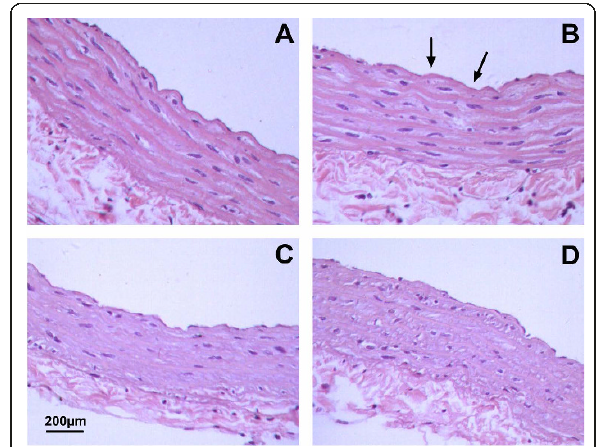
Figure 4 Representative sections (4 μ m thick) of H&E stained of thoracic aorta . ( A ) Control rats. ( B ) HF rats, with considerable damage in endothelial cells including disorder arrangement, unclear borderline and partial deletion (arrow). ( C ) HF + DMC rats, with less injury than observed in HF rats. ( D ) HF + ATV rats, with less injury than observed in HF rats. Scale bars represent 200 μ m.